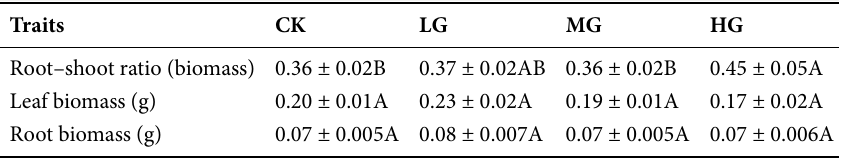
ActaSocietatisBotanicorumPoloniae / 2022 / Volume 91 / Article 913 Publisher: Polish Botanical